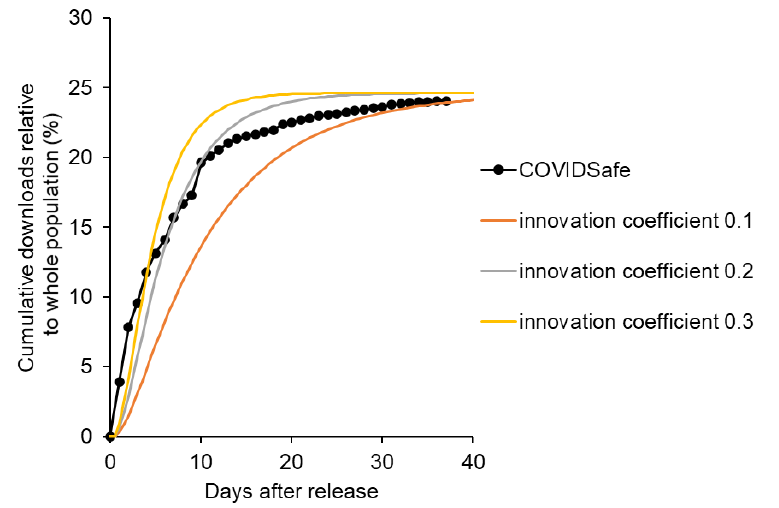
Figure 5. COVIDSafe’s conceptual system dynamics model on the number of downloads.